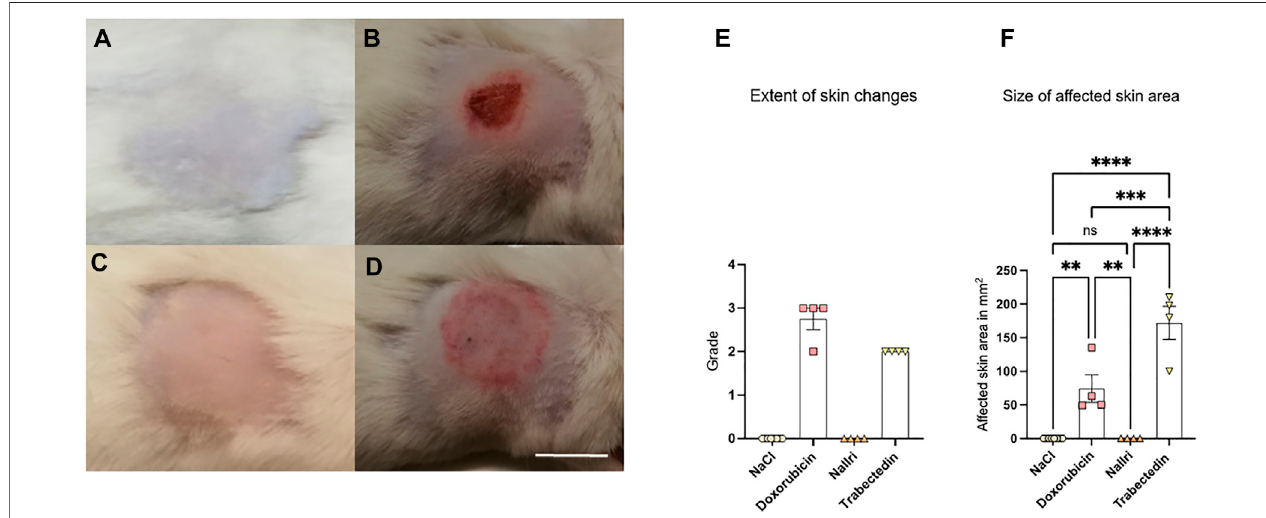
FIGURE 1 | Representative images of treated area of mice at day two after subcutaneous injection of (A) 150 µl or 300 µl NaCl (grade 0), (B) 150 µl doxorubicin (grade 3), (C) 300 µlnal-Iri(grade 0), (D) 150 µltrabectedin (grade 2). (E) Grading ofskin changeswhere grade 0wasassigned toall mice treatedwithNaClor nal-Iri. (F) Size of affected skin area with at least grade 2statistically analyzed using ANOVA followed by apost-hoc test with aTukey-B correction. ** p < 0.01, *** p < 0.005, **** p < 0.0001, ns = not signi fi cant. Scale bar = 1 cm.